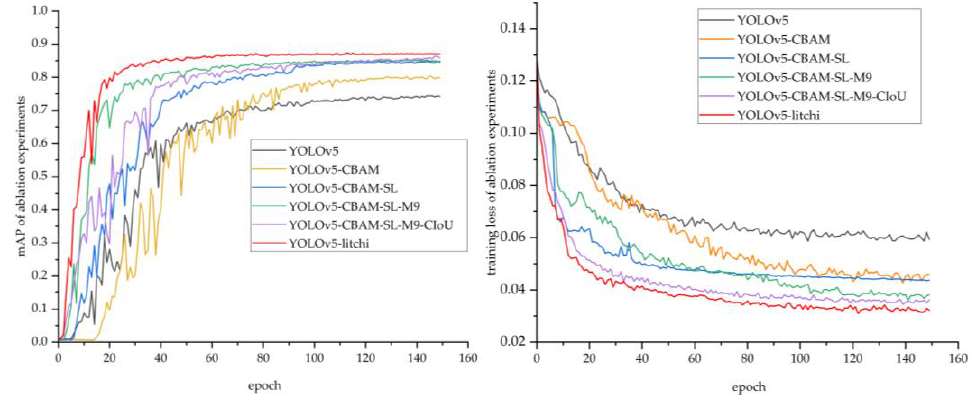
Figure 8. The mAP ( left ) and training loss ( right ) of the ablation experiments.